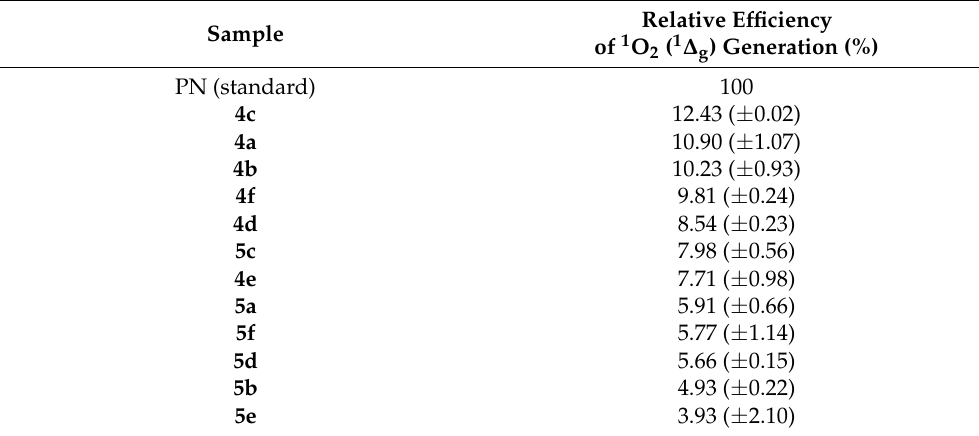
Table 1. Relative efficiency of singlet oxygen generation by studied samples calculated against the standard.